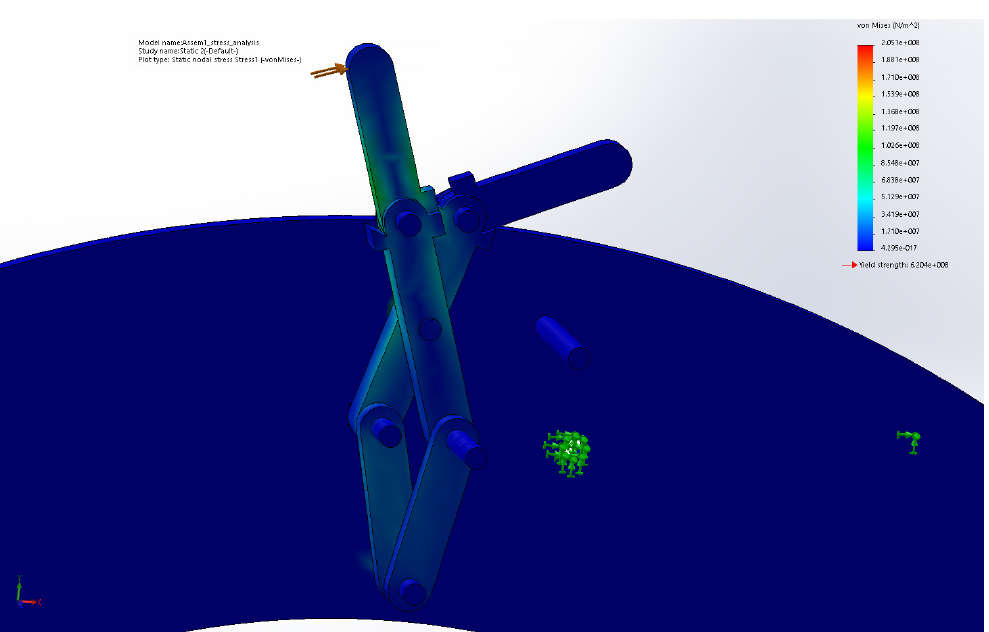
Figure 14. Von-Mises stress on chain 1 due to external loading (View 1).